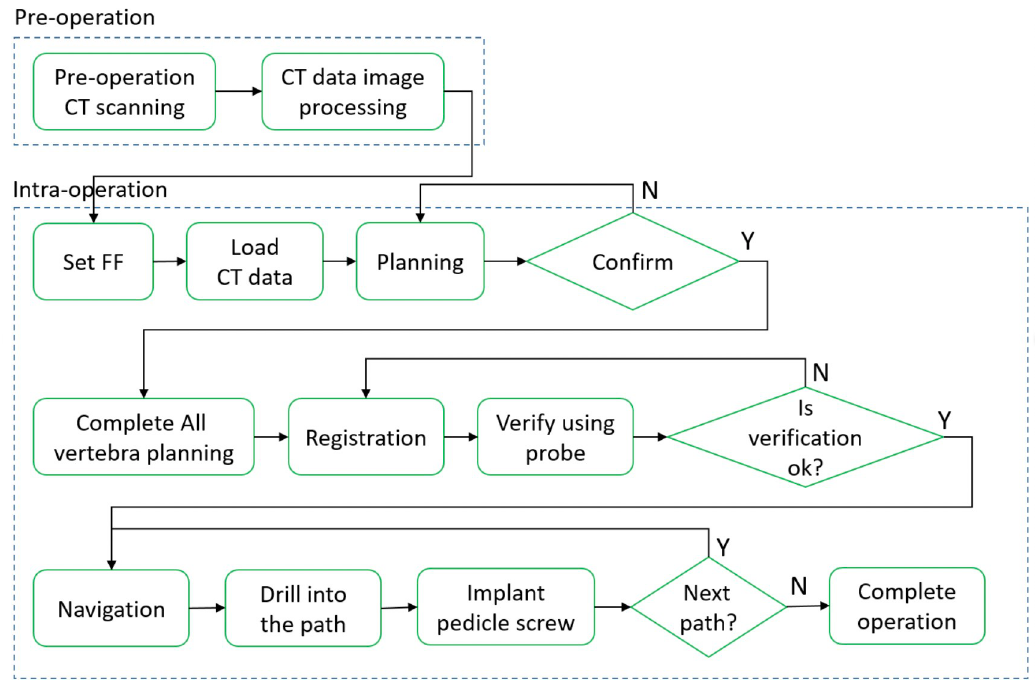
Fig 2. Procedure of screw placement operation using the